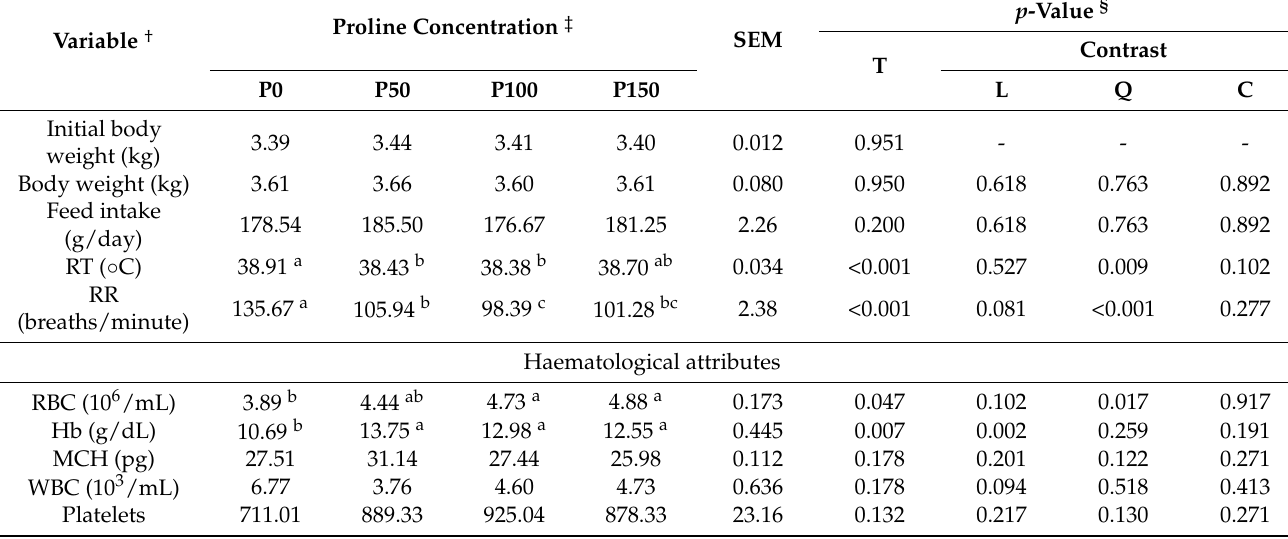
Table 3. Concentration-dependent effects of proline supplements on body weight, feed intake, rectal temperature, respiration rate, and haematological attributes of rabbit bucks during the experimental period; data are expressed as least square means ± standard errors of the mean